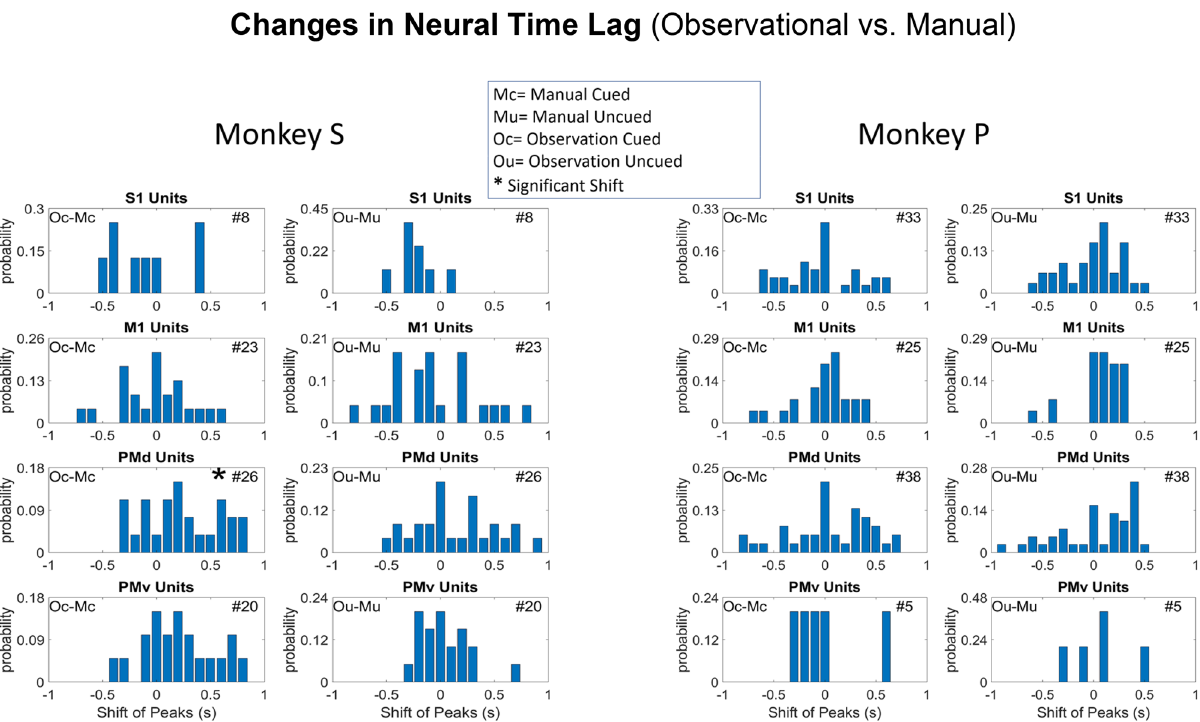
Figure 7. Changes in neural time lags where neural data best correlate with peak grip-force. Bar plots showing the shift of peak correlation between similar (cued/Uncued) Manual and Observational blocks for cS1, rM1, PMd, and PMv cortices (cortex is labeled on the title of each subplot). The shift from a block type to another block type (manual-to-observational) is at the top right of each subplot for each NHP (Mc = Manual Cued, Mu = Manual Uncued, Oc = Observation Cued, Ou = Observation Uncued). The number of units used is indicated in the upper right corner of each subplot. The left column for each NHP shows the shift between cued blocks, and the right column shows the shift between uncued blocks. An Asterisks (*) symbol before the number of units represents a significant (p < 0.01) shift in the histogram from manual to observational tasks. The probability of unit shifts was calculated by subtracting the peak correlation time bin position for manual from the observational tasks for the same unit. For more on this correlational analysis see Figs. S13 and